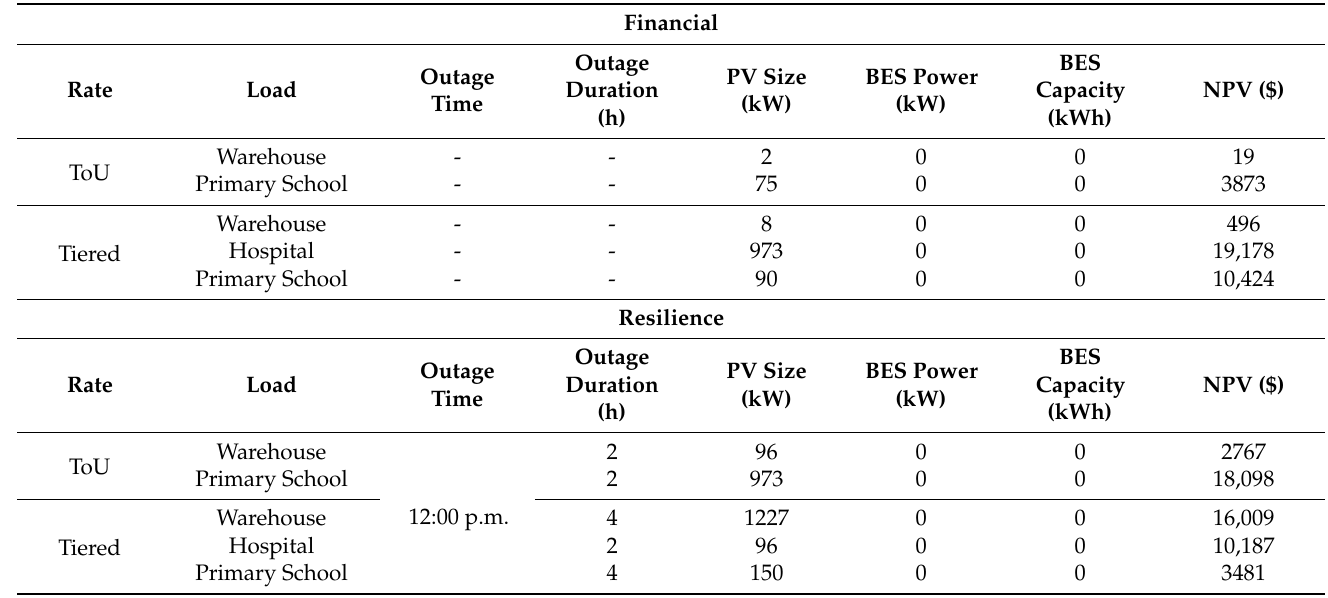
Table 2. Positive NPV results for the commercial loads in the Phoenix, AZ